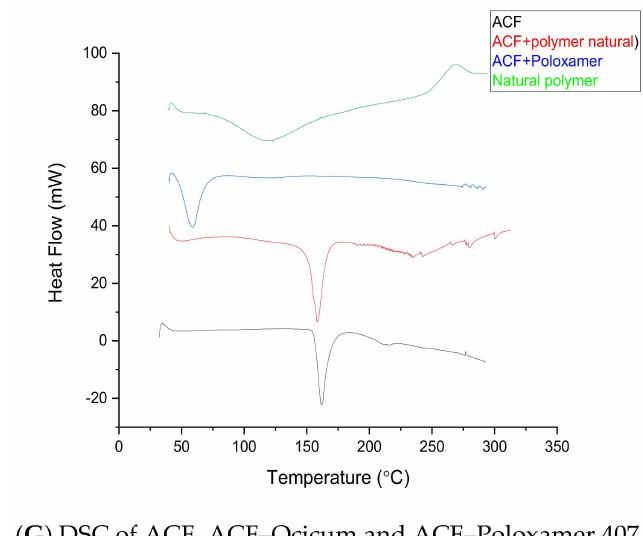
Figure 4. XRD and DSC of ACF and solid dispersions with polymers in solid dispersions. The X-ray diffractogram of Poloxamer included solid dispersions manifested charac- teristic peaks at 17.85 ◦ and 26.30 ◦ with 220 and 627 intensities for SE-ACF-1 and 17.49 ◦ and 26.30 ◦ at 161 and 363 intensities for SE-ACF-2 and at 17.64 ◦ and 25.94 ◦ at 102 and 200 intensities for SE-ACF-3 (Figure 4C). Similarly, solid dispersions of ACF prepared